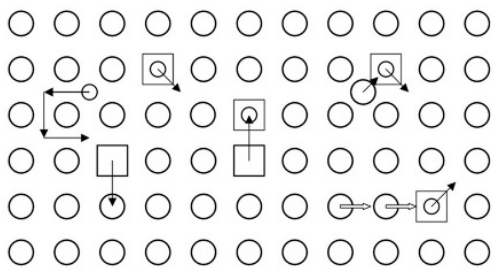
Figure 1. Schematic illustration of defect configurations and jump processes relevant for He diffusion without and with irradiation [8].